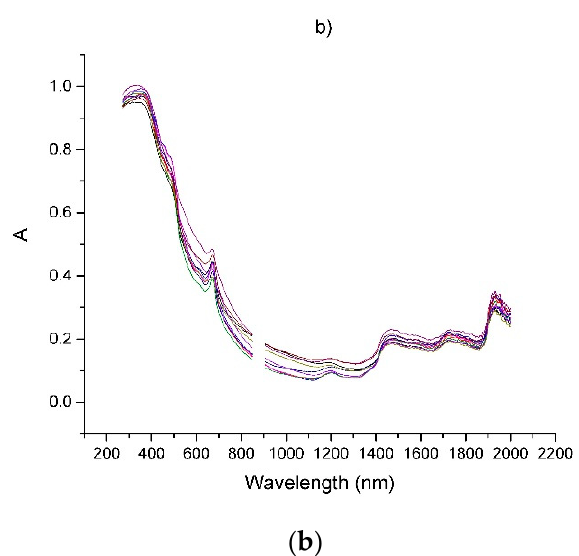
Figure 2. ( a ) Raw diffuse-reflectance spectra in the 250–2000nm range, obtained from dried Arnicae flos ; ( b ) the processed spectra after removing ranges with detector switching and straight light area. The samples are defined in Table 1.